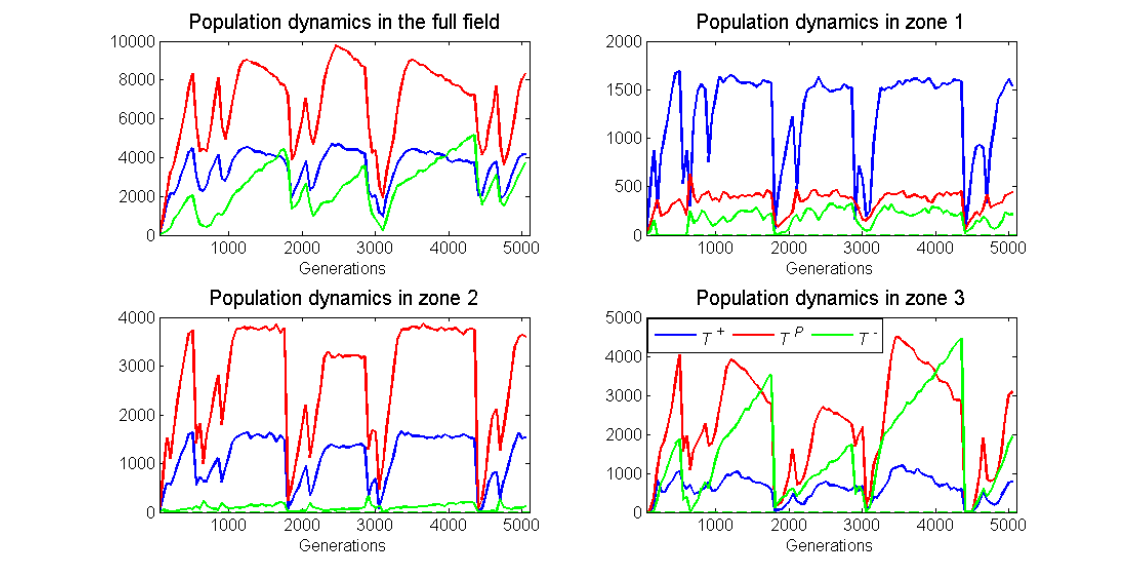
Figure 13. For dynamic blood vessels, population dynamics (same run as Figure 12) of the spatial game for each of the three cell types: across the whole space ( top left ); in zone 1 ( top right ); in zone 2 (bottom left ); and in zone 3 ( bottom right ). The blood vessel switches location with a low probability of 0.0025 per generation, neighborless cells can proliferate ( σ = 0.1), and the zones have a broad width ( r 1 = r 2 = r 3 = 5). With each blood vessel switch, populations crash and then quickly